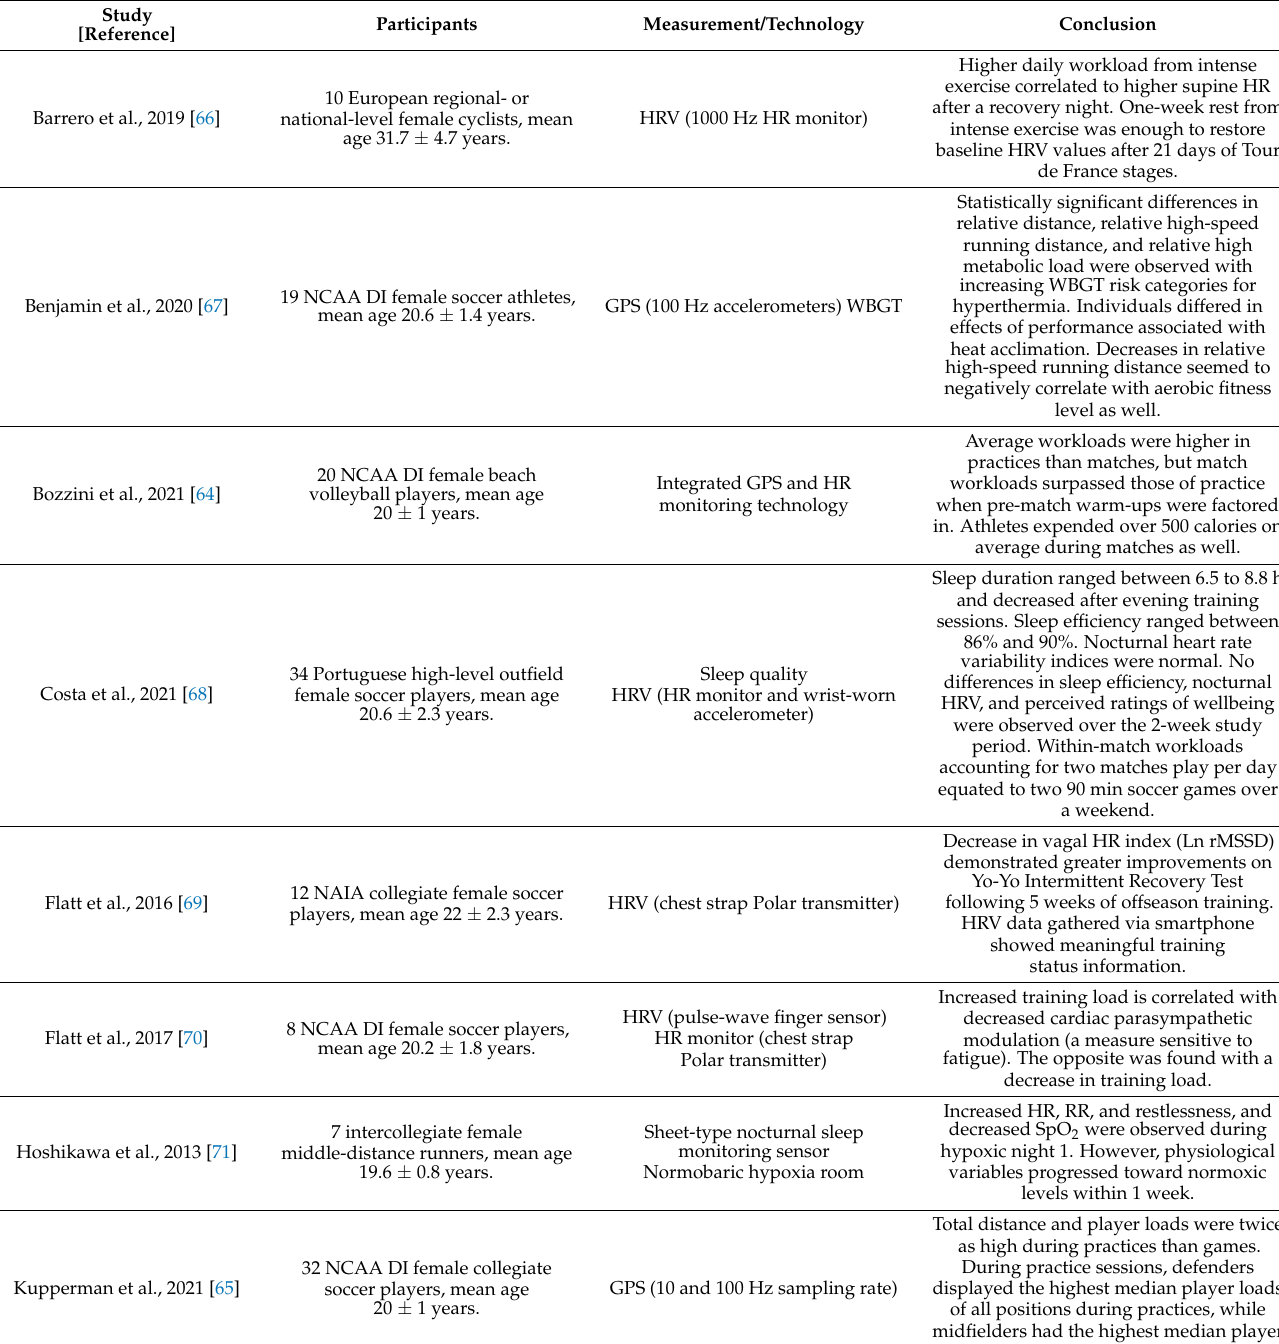
Table 4. Summary of technology in sports studies among female athletes